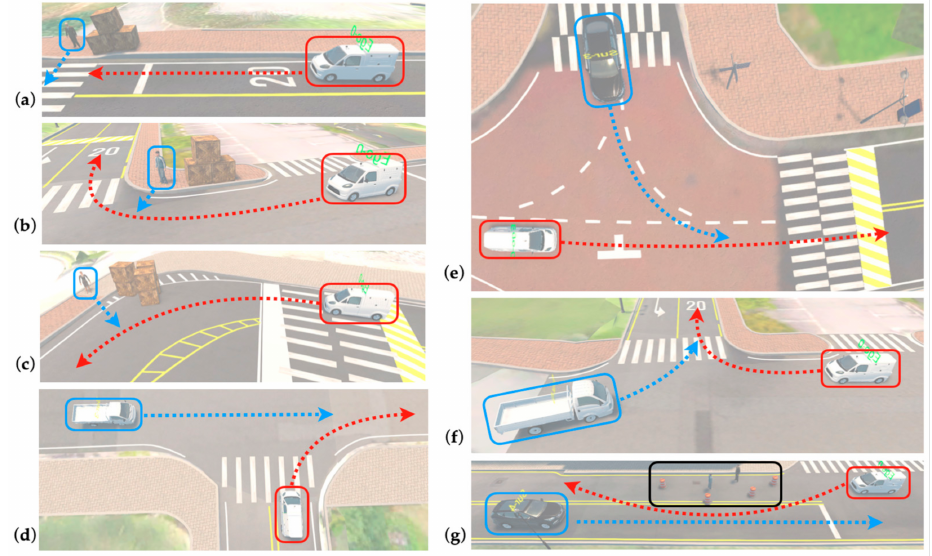
Figure 13. The hazardous scenarios: ( a – c ) these are regarded as moving pedestrians; ( d – g ) these are regarded as moving